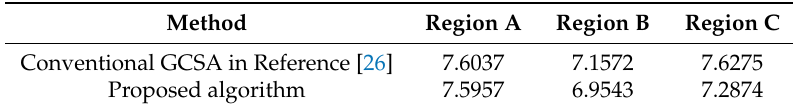
Figure 11. Zoom images. ( a – c ) Zoom images of subregions extracted from Figure 10a. ( d – f ) Zoom images of subregions extracted from Figure 10b. Table 4. Image entropy of the zoom